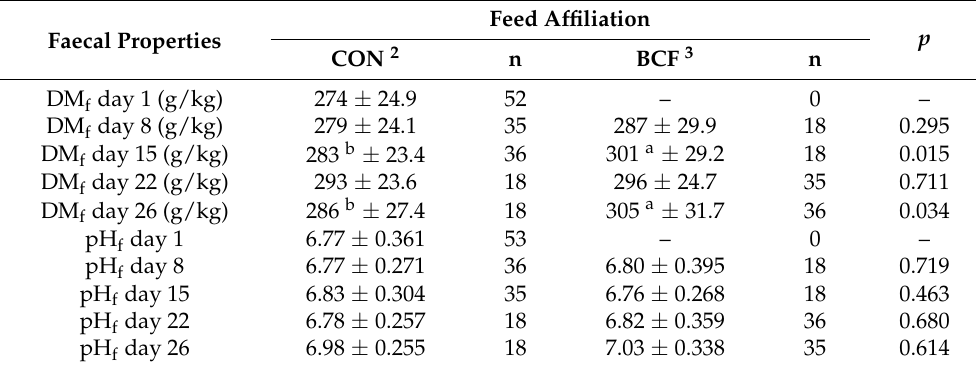
Table 3. Faecal dry matter content (DM f , mean ± SD) and faecal pH (pH f , mean ± SD) in dependence on feed affiliation 1 (CON,